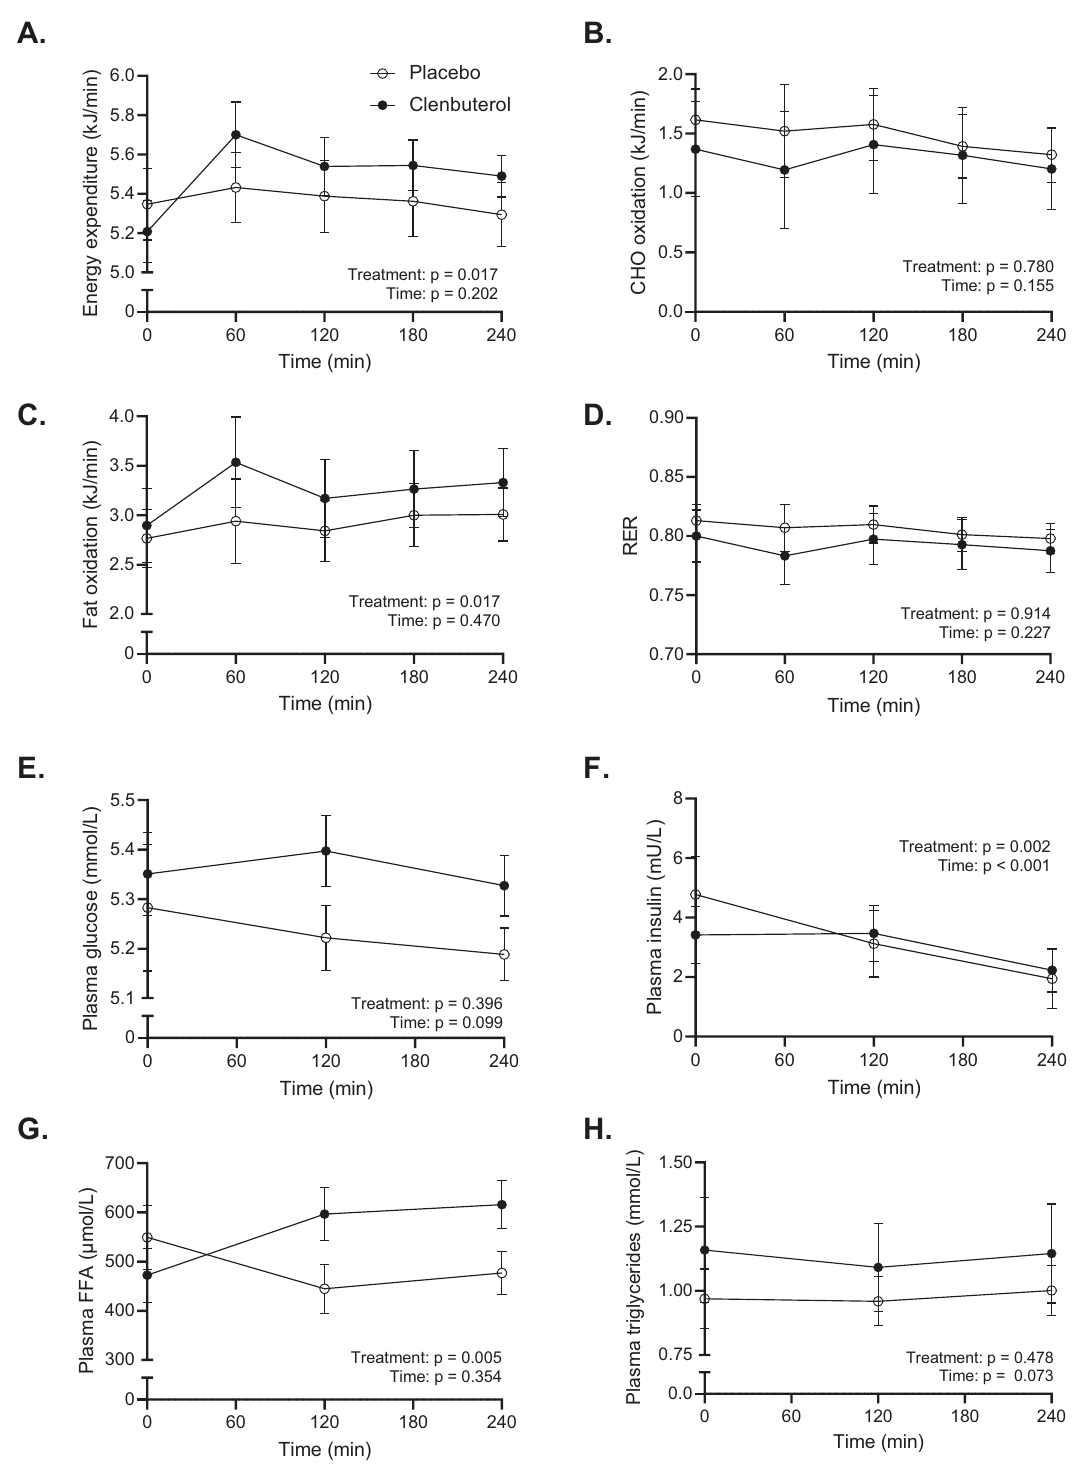
H.Plasmatriglycerideconcentrations(mmol/L). N =10forindirectcalorimetrydata and n=11 for plasma analyses. FFA=free fatty acids. All data were analysed by means of a linear mixed model analysis without correction for multiple compar- isons. Data are presented as mean±SEM. Source data are provided as a Source Data fi